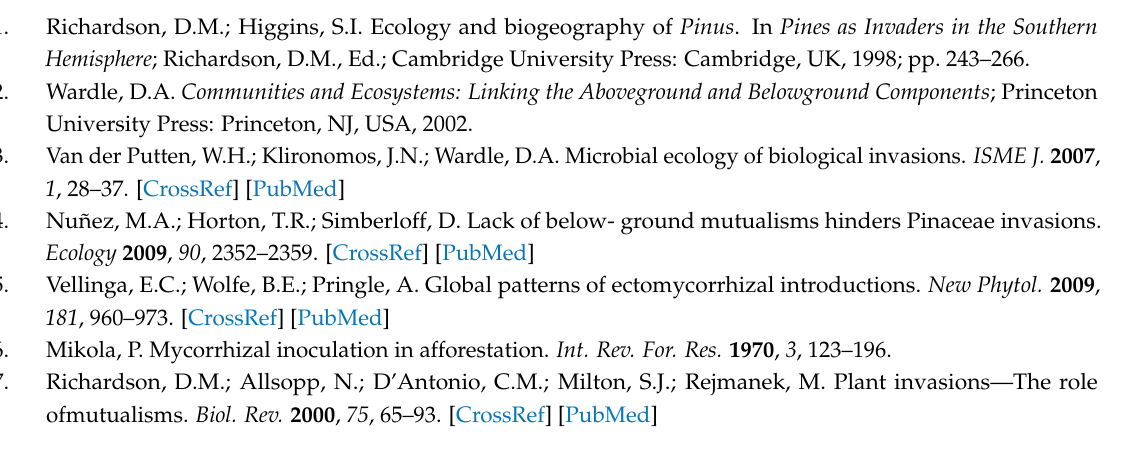
Figure S1: Map of sampling regime and sampling locations across the continental China. Circles represent individual sampling locations mapped on Google Map images. (A) Individual sampling plots are shown on a map of south China. (B) Individual plots 20 × 20 m within a sampling site are shown in Longli Forest Farm, Guizhou. (C) Individual plots 20 × 20 m within a sampling site are shown in Hunan Botanic Garden, Hunan. lat, latitude; lon, longitude, Table S1: Soil physico-chemical characteristics among different habitats, Table S2: Comparison of sequence abundances and operational taxomomic unit (OTU) counts in a mock community of 18 Basidiomycota species collected in local